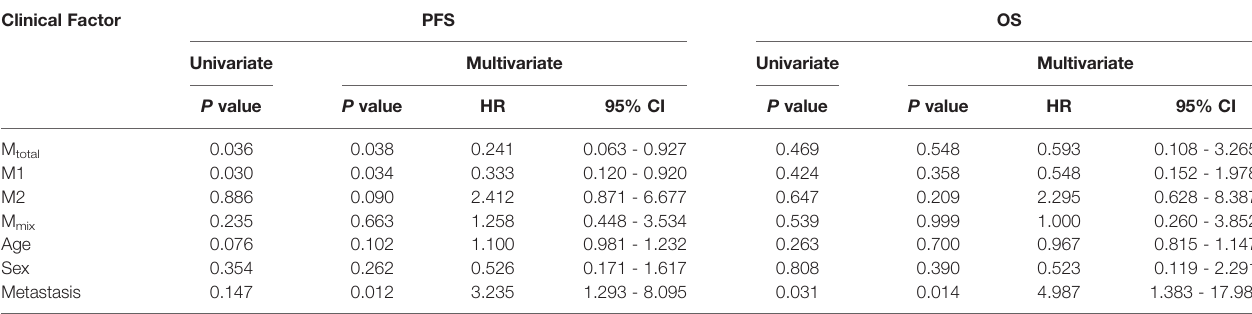
TABLE 2 | Univariate and multivariate analyses of clinical variables associated with PFS and OS. Clinical